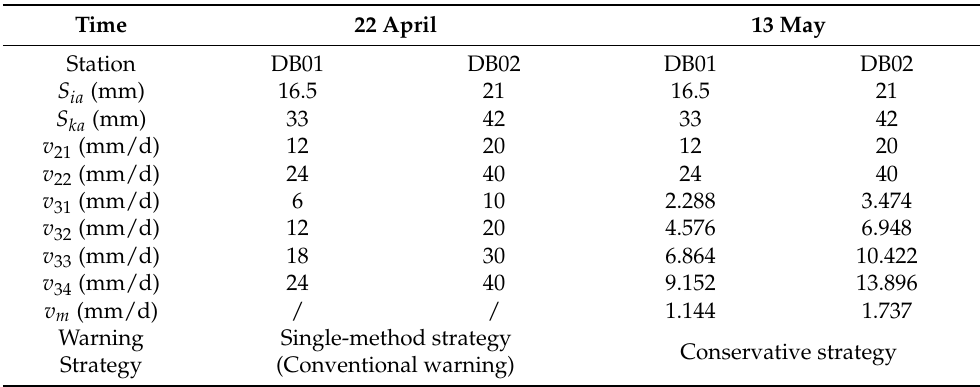
Table 3. The thresholds of the Lishanyuan